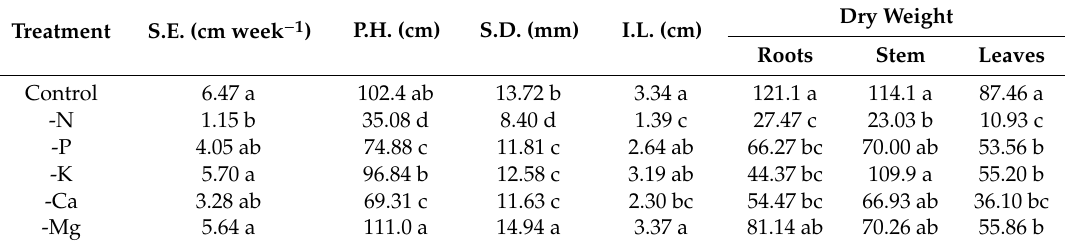
Table 2. Vegetative growth of fig tree plants under macronutrient deficiency.